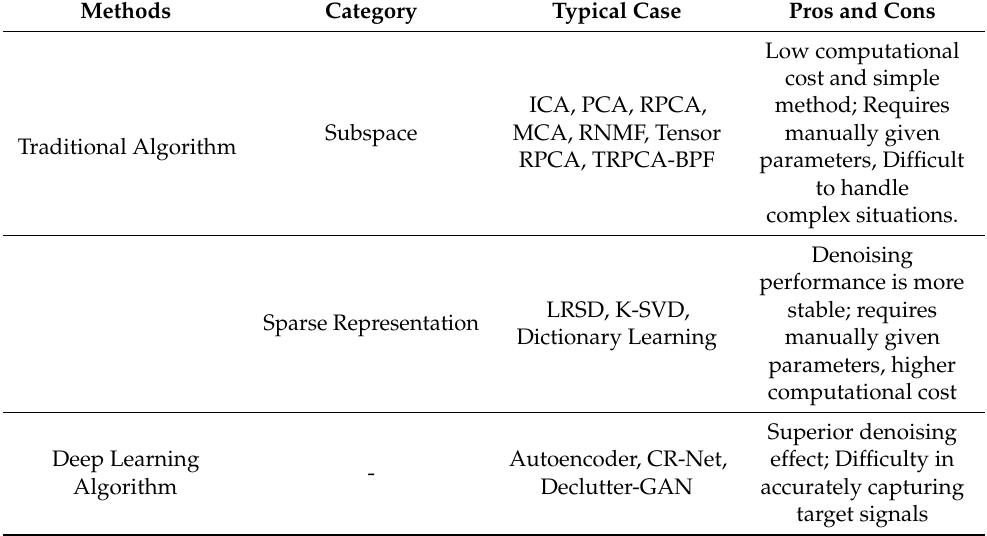
Table 1. Progress in GPR clutter-removal